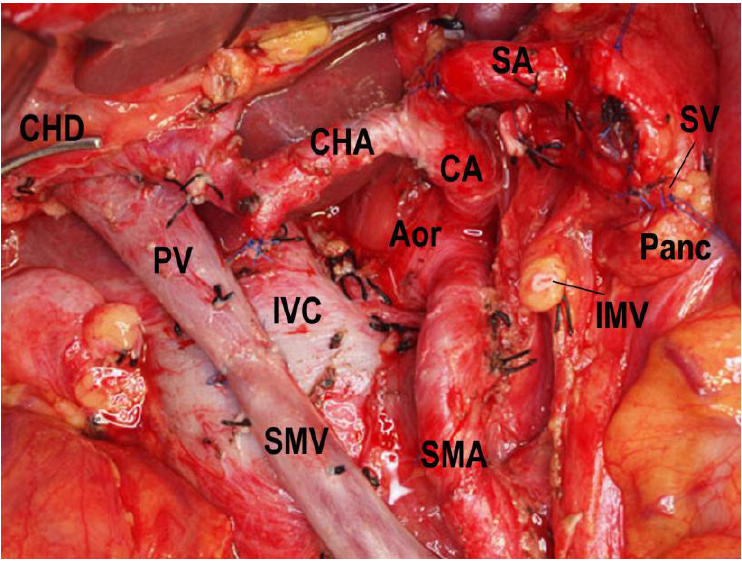
Figure 4. Isolated PD combined with portal and superior mesenteric veins resection, para-aortic lymph node dissection, and reconstruction of the portal vein by end-to-end anastomosis is done under catheter-bypass of the portal vein. PV, portal vein; SMV, superior mesenteric vein; CHA, common hepatic artery; SA, splenic artery; SV, splenic vein; CA, celiac artery; Aor, aorta; IMV, inferior mesenteric vein; Panc, pancreas; CHD, common hepatic duct; IVC, inferior vena cava; SMA, superior mesenteric